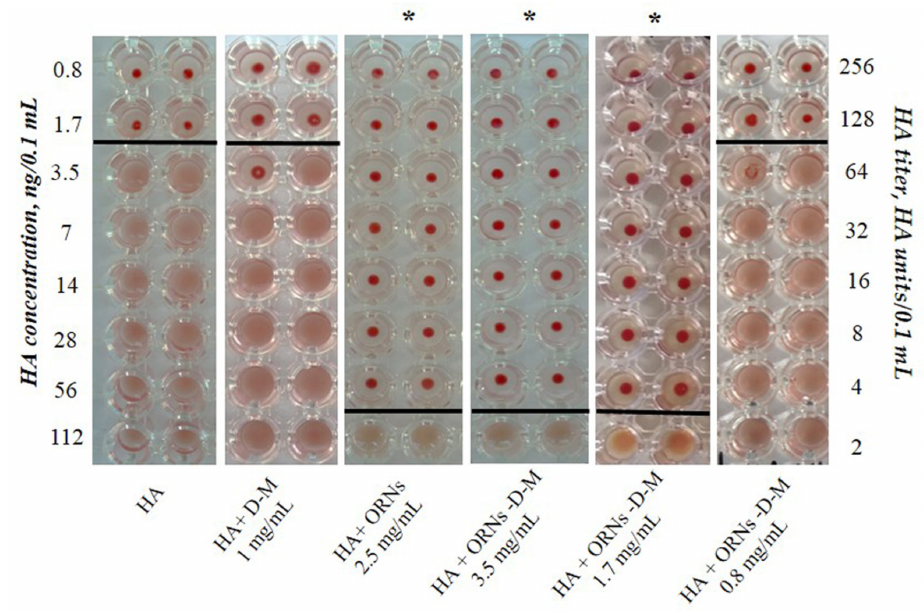
Figure 2. The erythrocyte agglutination mediated by the HA proteins (Vaxigrip). View of the hemag- glutination reaction mixtures displayed in a round-bottomed microwell plate after the addition and dilution of the HA, which was pre-incubated with ORNs and ORNs-D-M in concentrations of 0.8–3.5 mg/mL. The picture demonstrates one of five independent experiments. Statistical signifi- cance was evaluated using the Student’s t -test, relative to the control HA ( p <